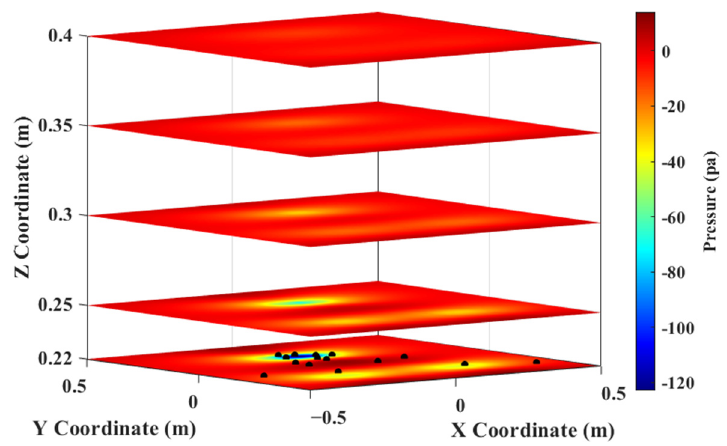
Figure 20. Reconstructed pressure nephograms with optimal sensor locations (Boundary Condition 1).